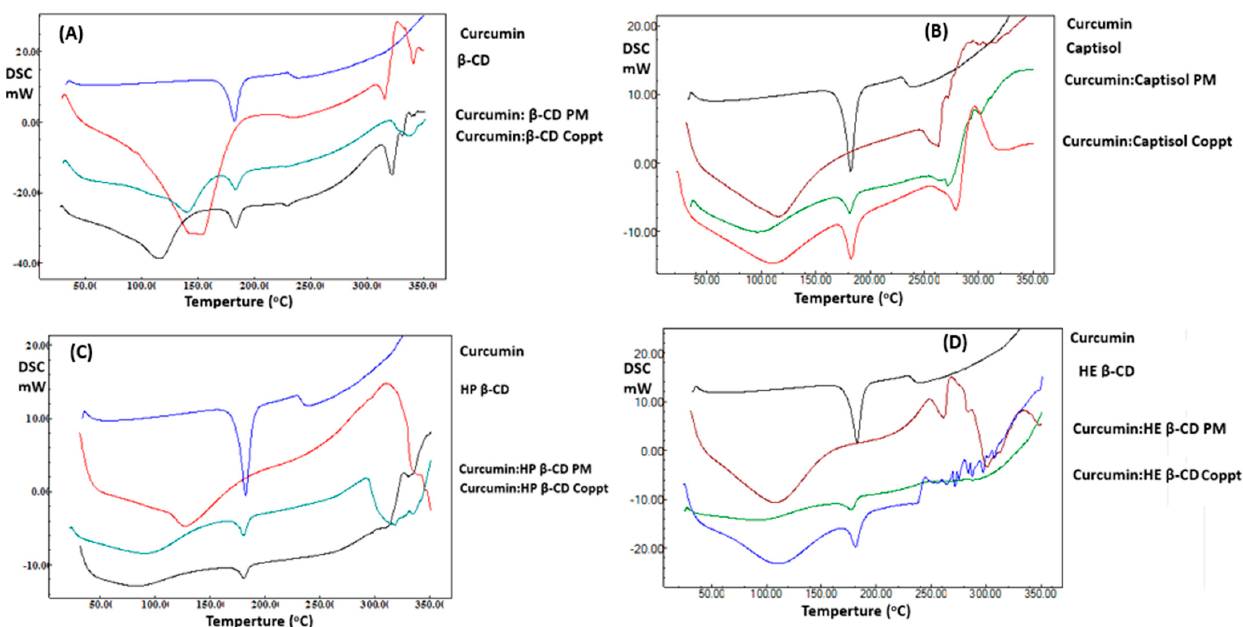
Figure 3. A–D . DSC thermograms of curcumin, curcumin: cyclodextrin complexes β -cyclodextrin ( A ), Captisol ( B ), hydroxypropyl β -cyclodextrin ( C ), and hydroxyethyl β -cyclodextrin ( D ) prepared by